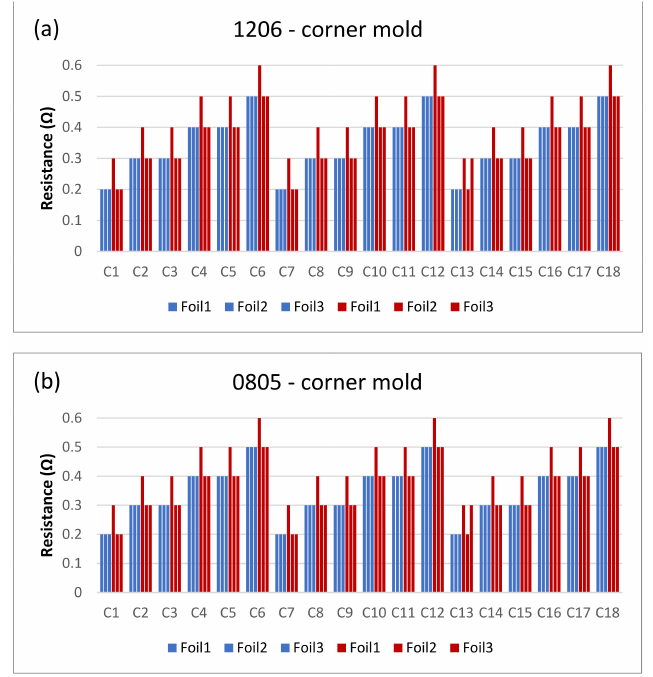
Figure 17. Resistance measurements for 1206 resistors ( a ) and 0805 resistors ( b ) molded in corner mold. Blue bars (before over-molding) and red bars (after